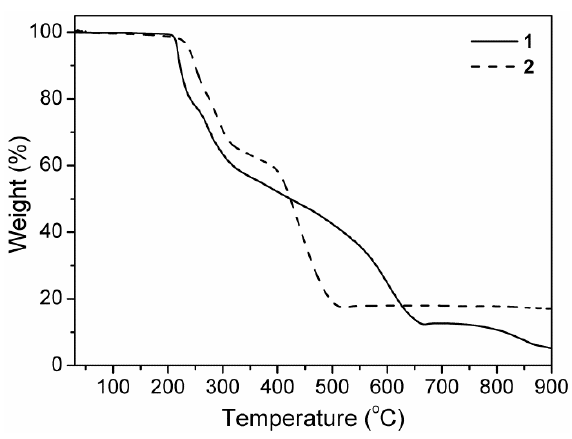
Figure 3. The thermogravimetric (TG) diagrams of 1 and 2 .